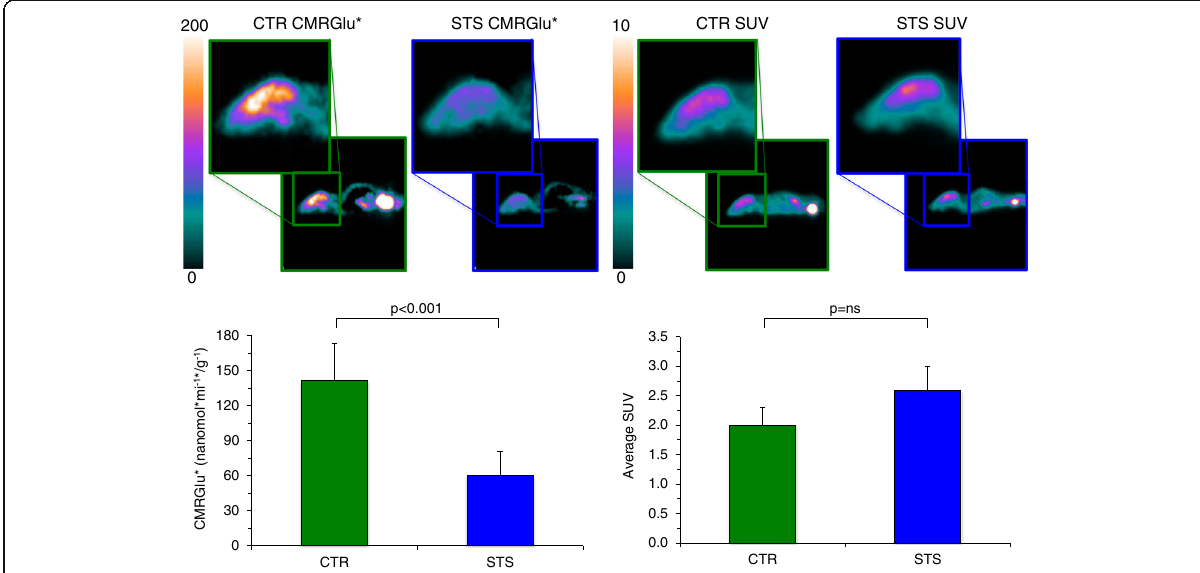
Fig. 1 In vivo effect of STS on brain metabolism. In the upper part, on the left, brain parametric maps of representative control (CTR) and 48-h starved (STS) mice are shown; representative images of basal metabolic activity of the whole brain expressed in average standardized uptake value (SUV) are shown on the right. In the bottom, graphs of whole cerebral metabolic rate of glucose (CMRGlu*; nmol × min − 1 × g − 1 ) and SUV are displayed, respectively. Results indicate mean±SD of nine mice per group; green bars represent control value, and blue bars represent STS